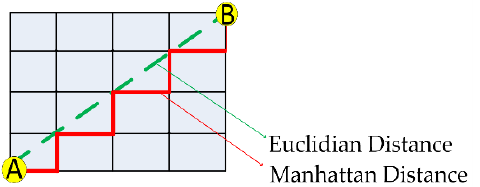
Figure 5. Components of target-tracking